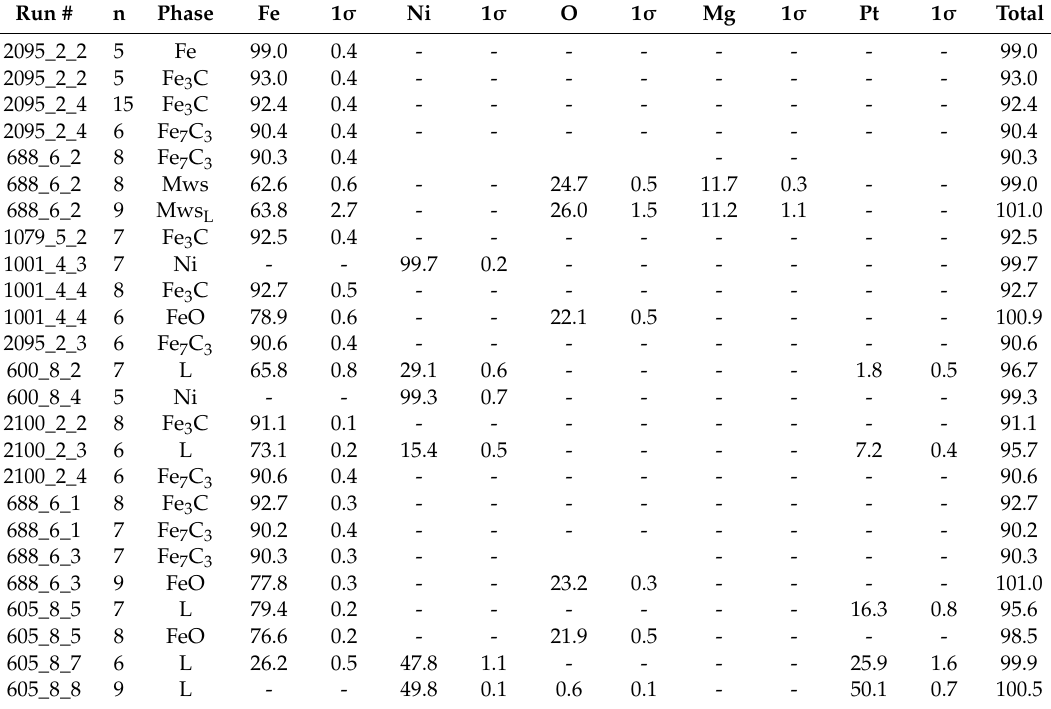
Table 2. Chemistry of metal phases according to EDS microanalysis (wt %).